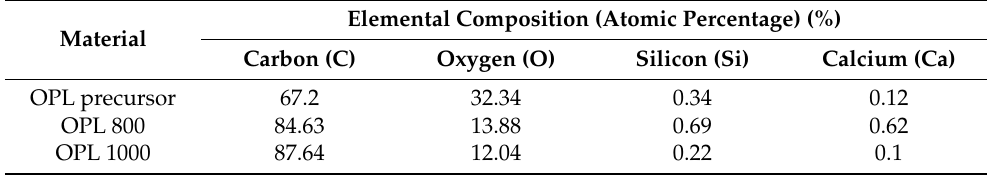
Table 1. Elemental composition of OPL precursor and OPL derived